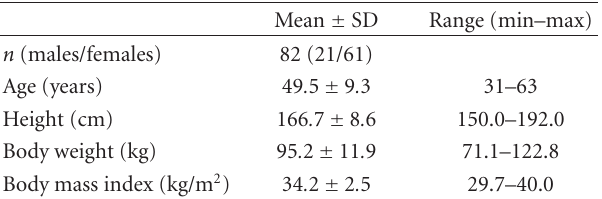
Table 1: Baseline characteristics of the subjects completing the